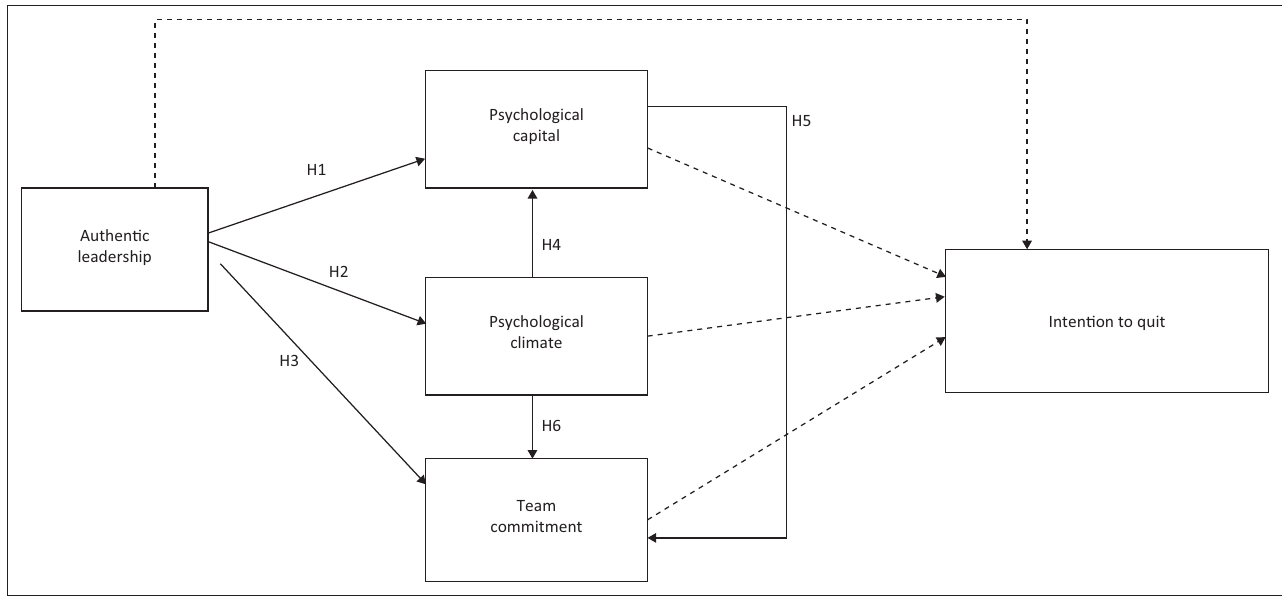
FIGURE 1: Proposed research